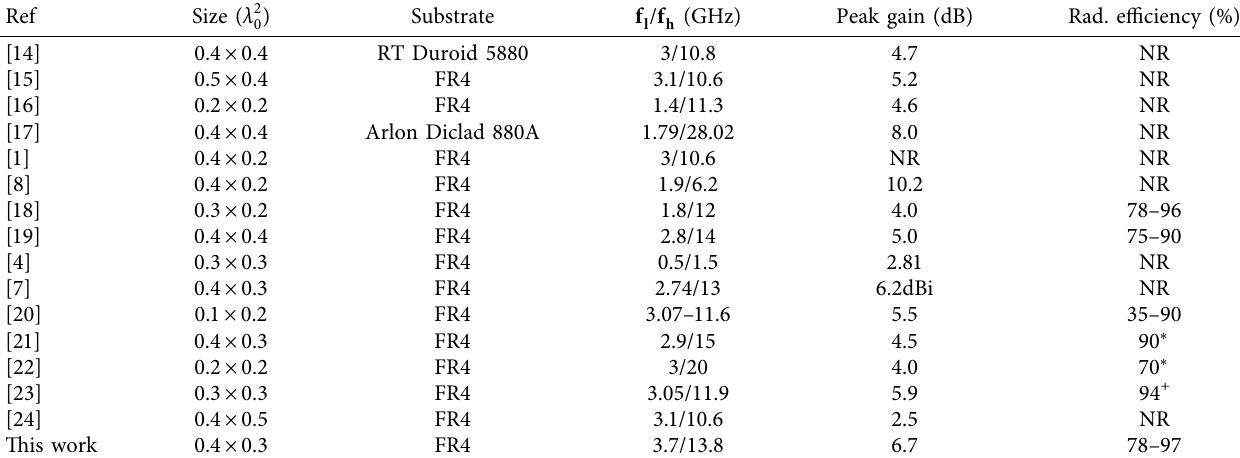
Table 3: Comparative analysis of VBi-UWBA with the existing